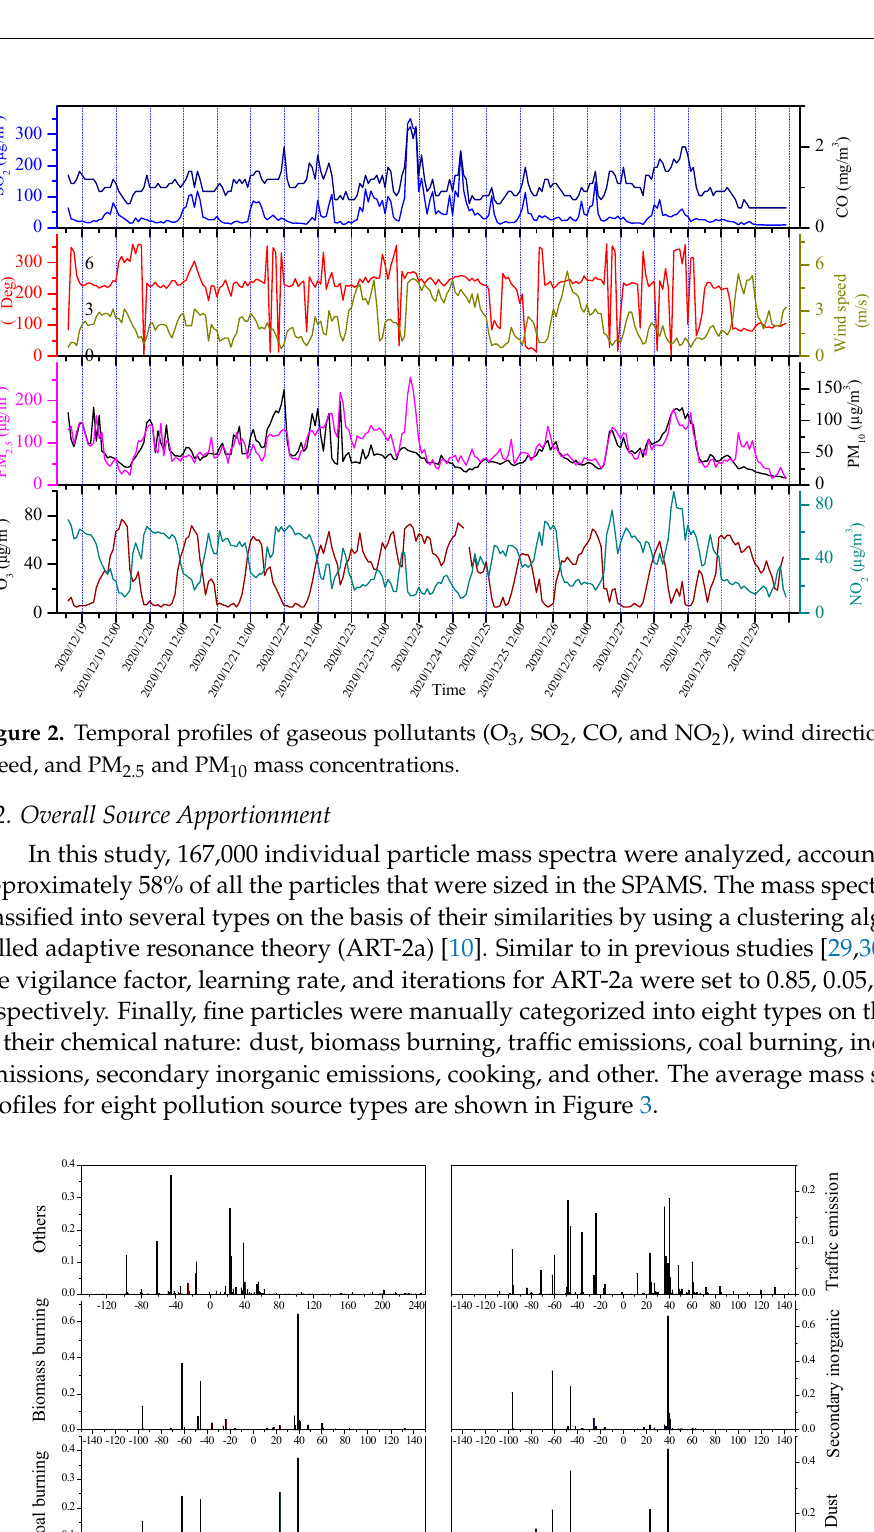
Traffic emission Industrial emission Secondary inorganic Biomass burning Dust Others Cooking Figure 4. Number fractions for each group during sampling period.